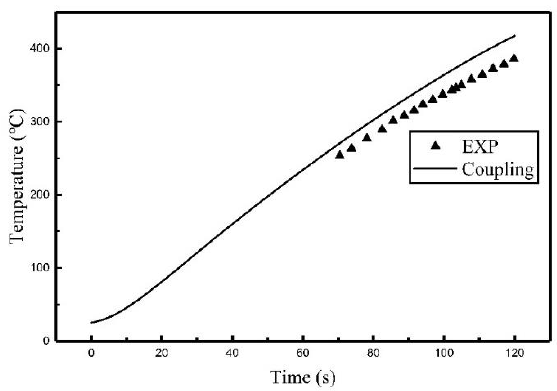
Figure 10. Coupling calculation model.